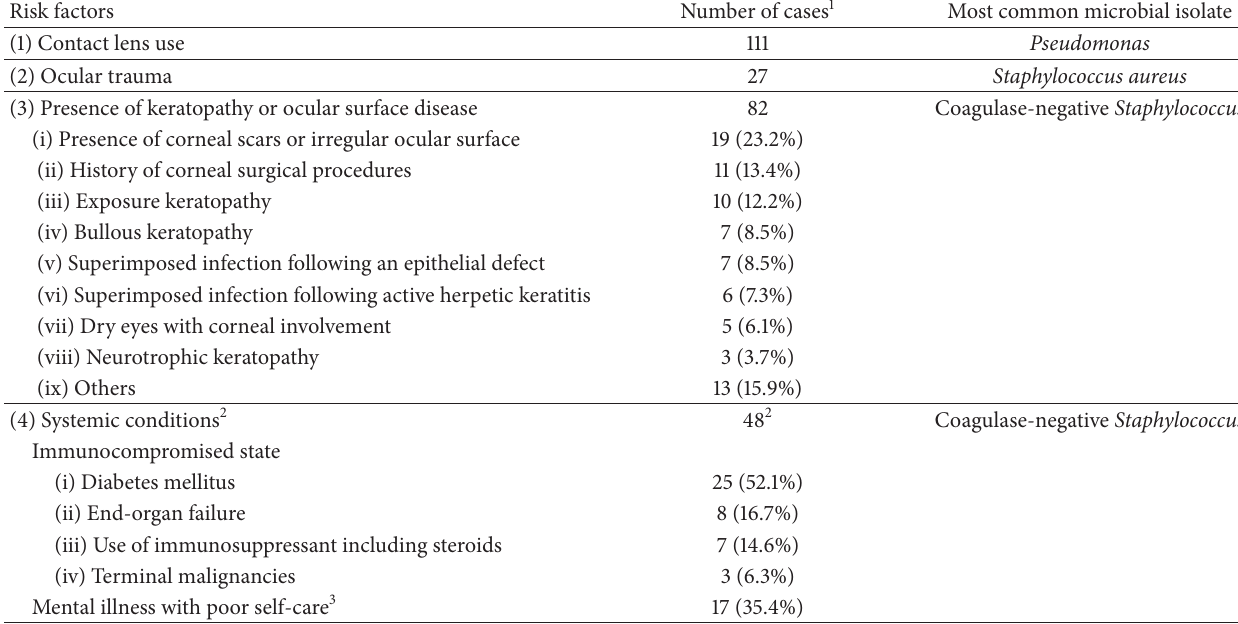
Table 1: Risk factors for microbial